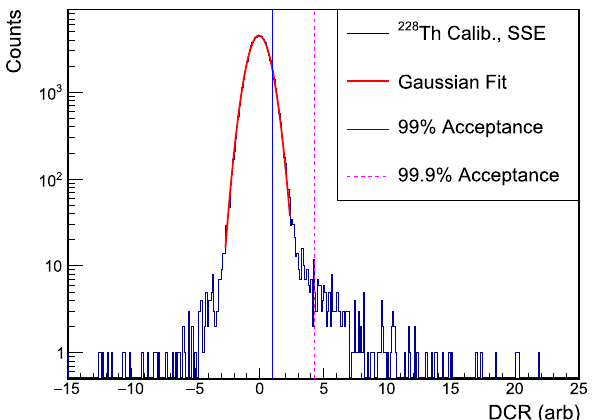
Fig. 5 TheDCRdistributionina 228 Thcalibrationdataset.Non-muon single-site events with energies between 1 and 2.63MeV are used to calibrate the DCR parameter. The centroid of a Gaussian fit (shown in red) is used to shift the tail slope δ , and the distribution is normalized to the 99% acceptance value (in blue). The 99.9% acceptance value (shown as a dashed violet line) is also provided for reference